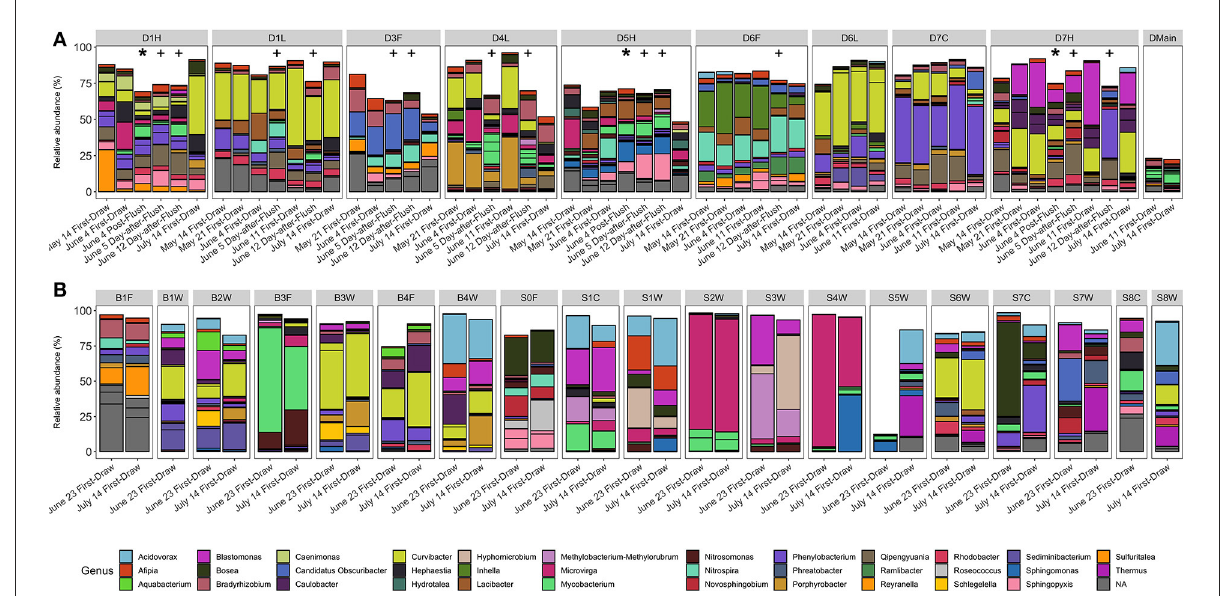
FIGURE5 Relative abundance (%) of ASVs in (A) building D and (B) residence halls grouped by fixture. Segments are ASVs representing at least 5% of two samples, and colors are genera. Asterisks (*) indicate post-flush samples, and plus signs ( + ) indicate 1-day-after-flush samples. Facets are by fixture ID which are written as one letter indicating the building (D, B, S), followed by the floor number (0–7), followed by one letter indicating the fixture type (W, shower; L, laboratory faucet; F, drinking fountain; H, hot/mixed faucet; C, cold